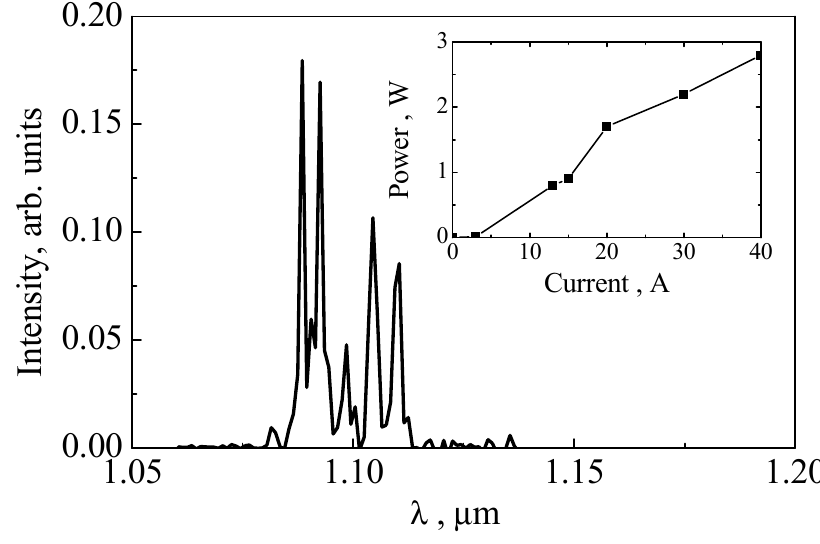
Figure 7. The emission spectrum of a strip laser based on the structure F at a current of 40 A (current density of 265 kA/cm 2 ). The inset shows the power-current characteristic of this laser.